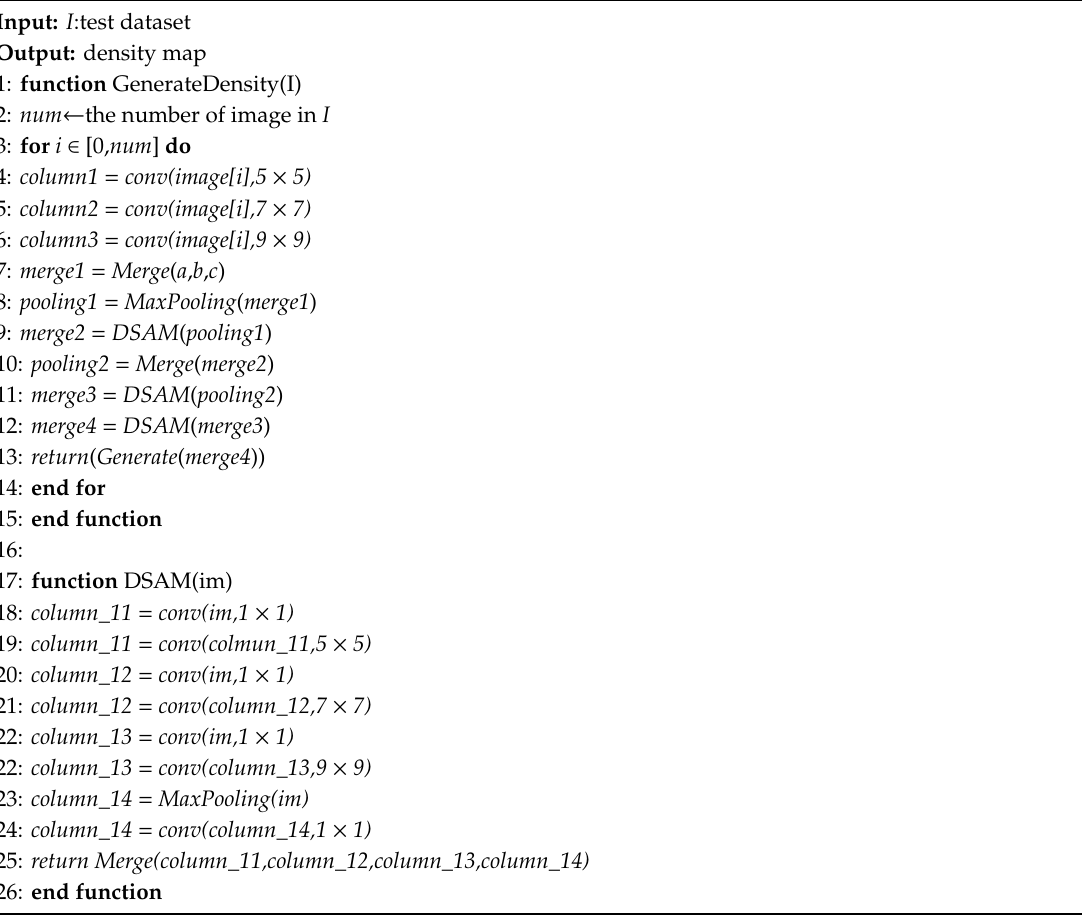
Algorithm 1: The calculation of density map for crowd